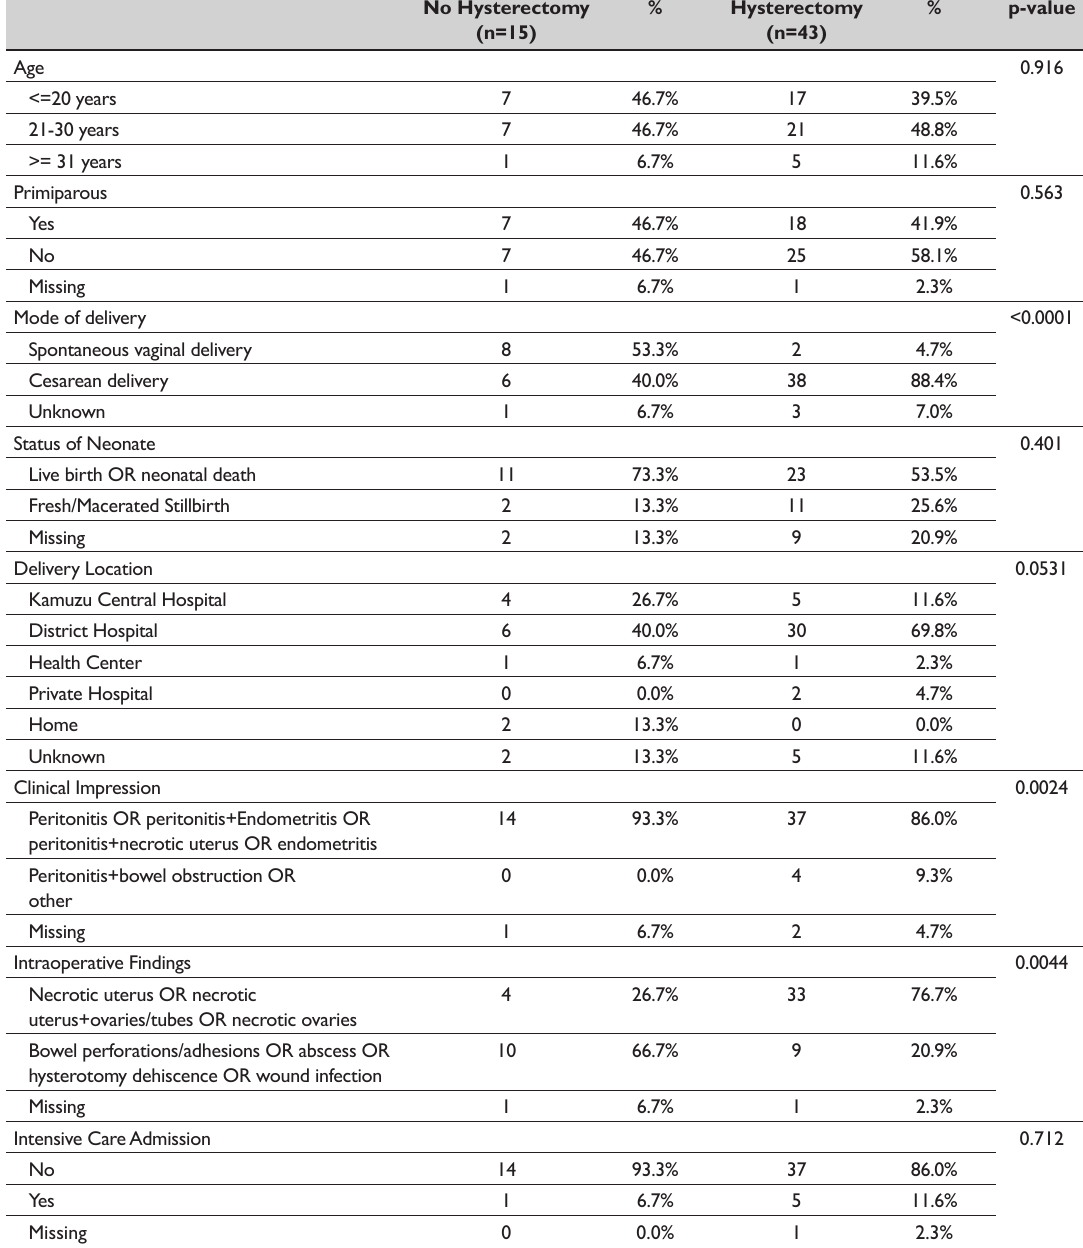
Table 3: Factors associated with hysterectomy